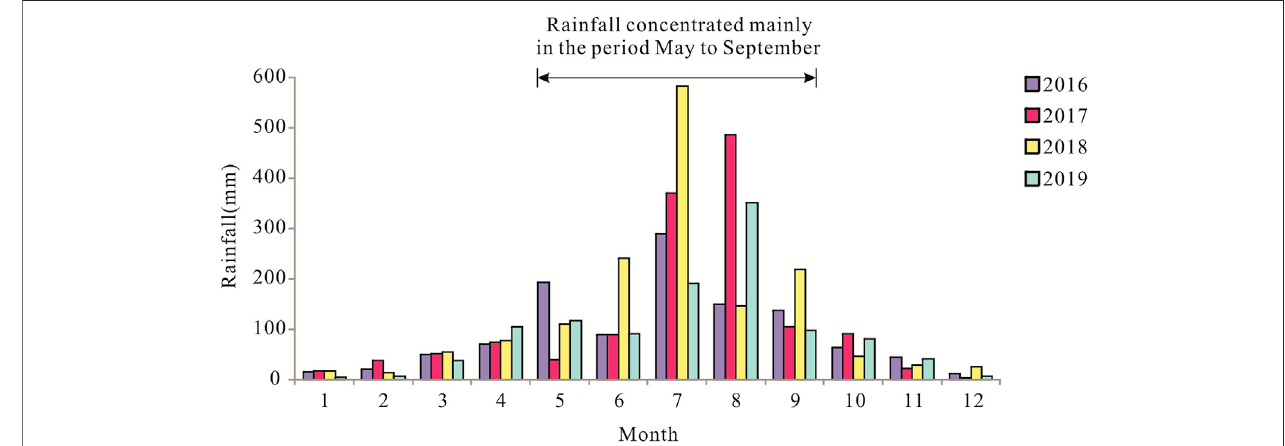
FIGURE 4 | The distribution of rainfall in Wenchuan County from 2016 to 2019 (measured at the Dujiangyan Station).